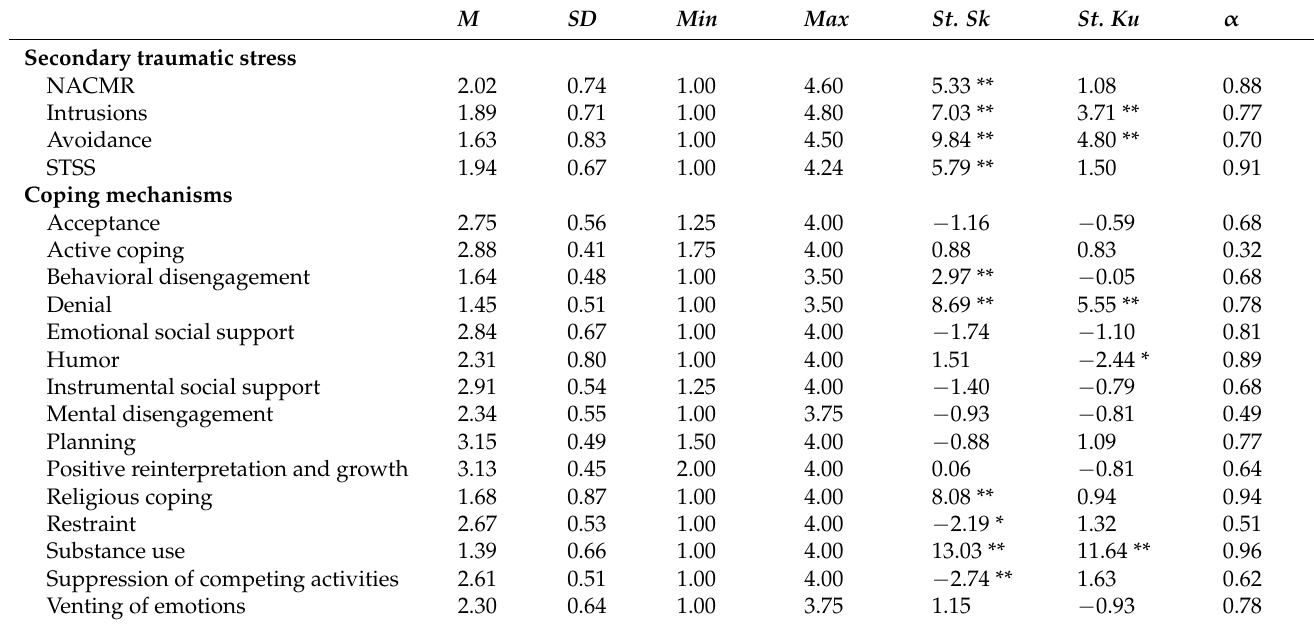
Table 1. Descriptive statistics for coping mechanisms and secondary traumatic